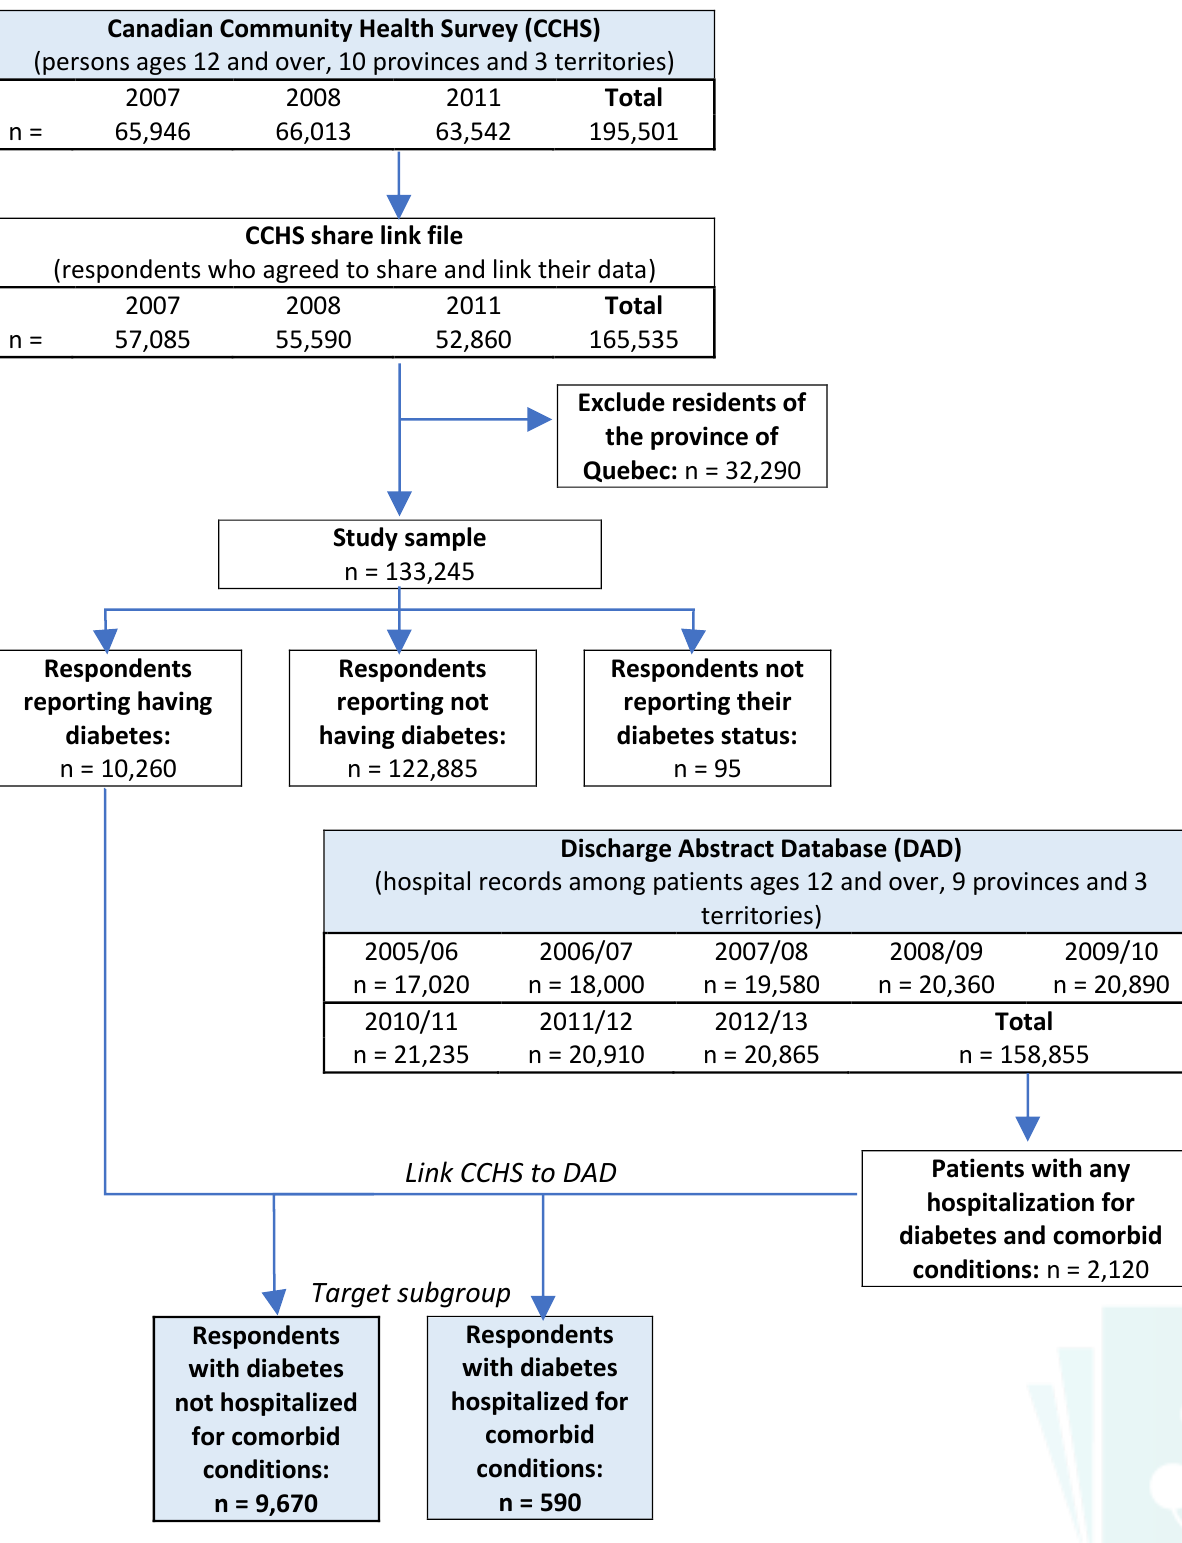
Figure 1: Flow chart for the creation of analysis file from linked health survey and hospital data Canadian Community Health Survey